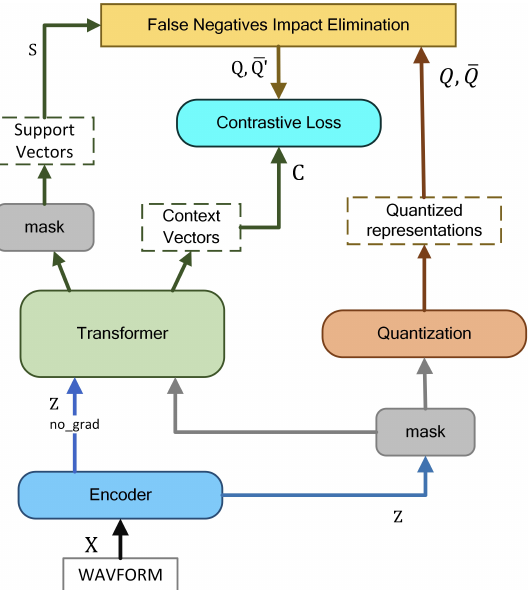
Figure 4. Illustration of the optimized model framework. Support Vectors and Negatives calculate the similarity and take the top-k similarity as false negative samples, which are deleted or absorbed as positive